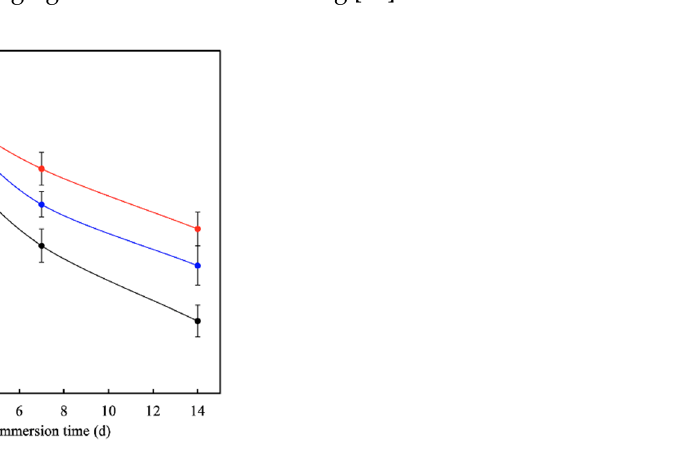
Figure 2. ( A ) Tensile stress–strain curves and ( B ) microstructure of the various Si-GelMa hydrogels.